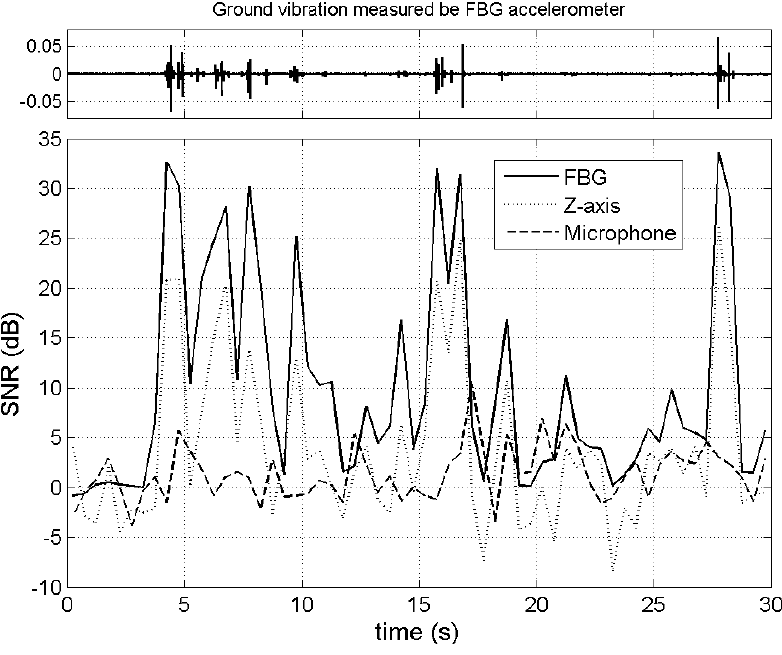
Figure 7. Signal-to-noise ratio (SNR) of signals detected by FBG accelerometer, Z-axis of geophone, and microphone. The upper subplot was the ground vibration signal detected by FBG